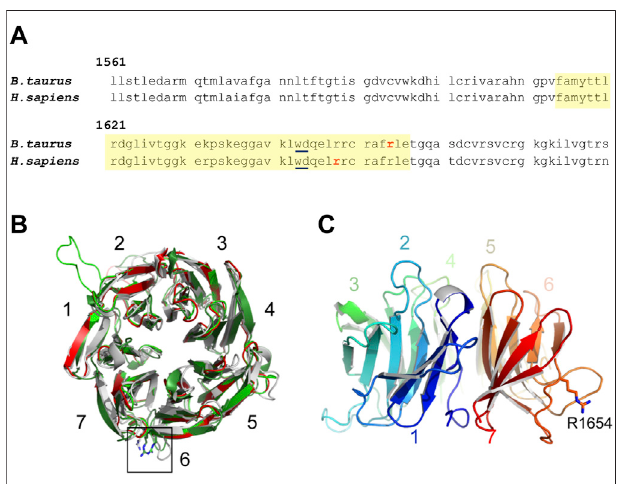
FIGURE1|(A) AminoacidsequenceofaWD40domainrepeatofEML5 in B. taurus and H. sapiens . The residues ofthe WD40 domain are highlighted in yellow. The affected arginine residue in bovine and the affected arginine residue predicted to cause cancer in humans are bolded in red. (B) Top view of models of the N-terminal β -propeller of the EML5 TAPE domain (residues G1378-S1698), generated by HHpred/MODELLER (light green), TrRosetta/YASARA (dark green), or AlphaFold2 (grey) and superimposed onto the crystal structure of the corresponding region of EML1 (red) (Richards et al., 2014). Numbers indicate the seven blades of the β -propeller, with a blackboxhighlightingthepredictedpositionofEML5R1654,depictedinstick representation. (C) Side view of the AlphaFold2 model, rainbow-colored from the N-terminus (blue) to the C-terminus (red) to highlight the relative arrangement of the blades. Note how the side chain of R1654 is predicted to protrude into the